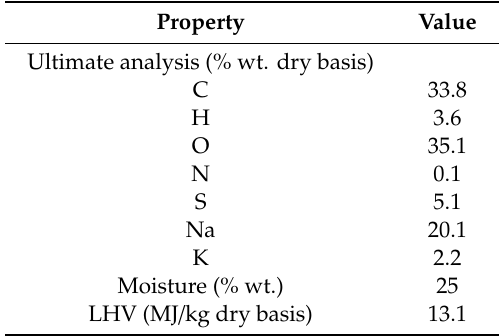
Table 2. Composition and properties of black liquor